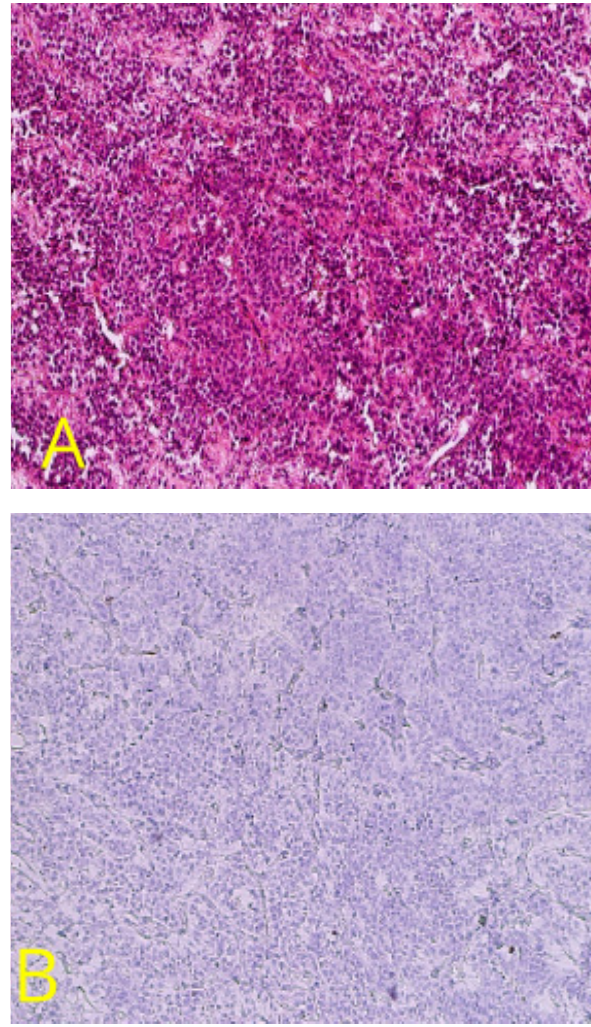
Fig. 4. A – histological examination (hematoxylin-eosin stain- ing, 40x magnification), demonstrating the pituitary adenoma tissue. B – immunohistochemistry examination without signs of increased Ki67 proliferation.